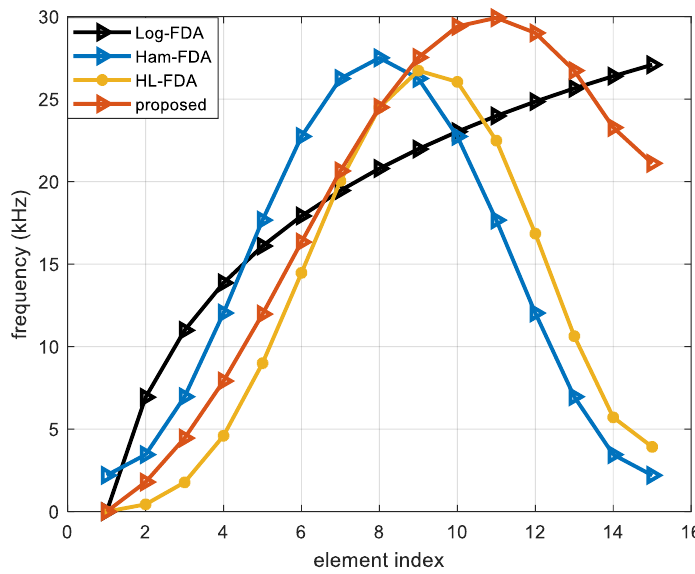
Figure 3. Relationship between array element index and position.